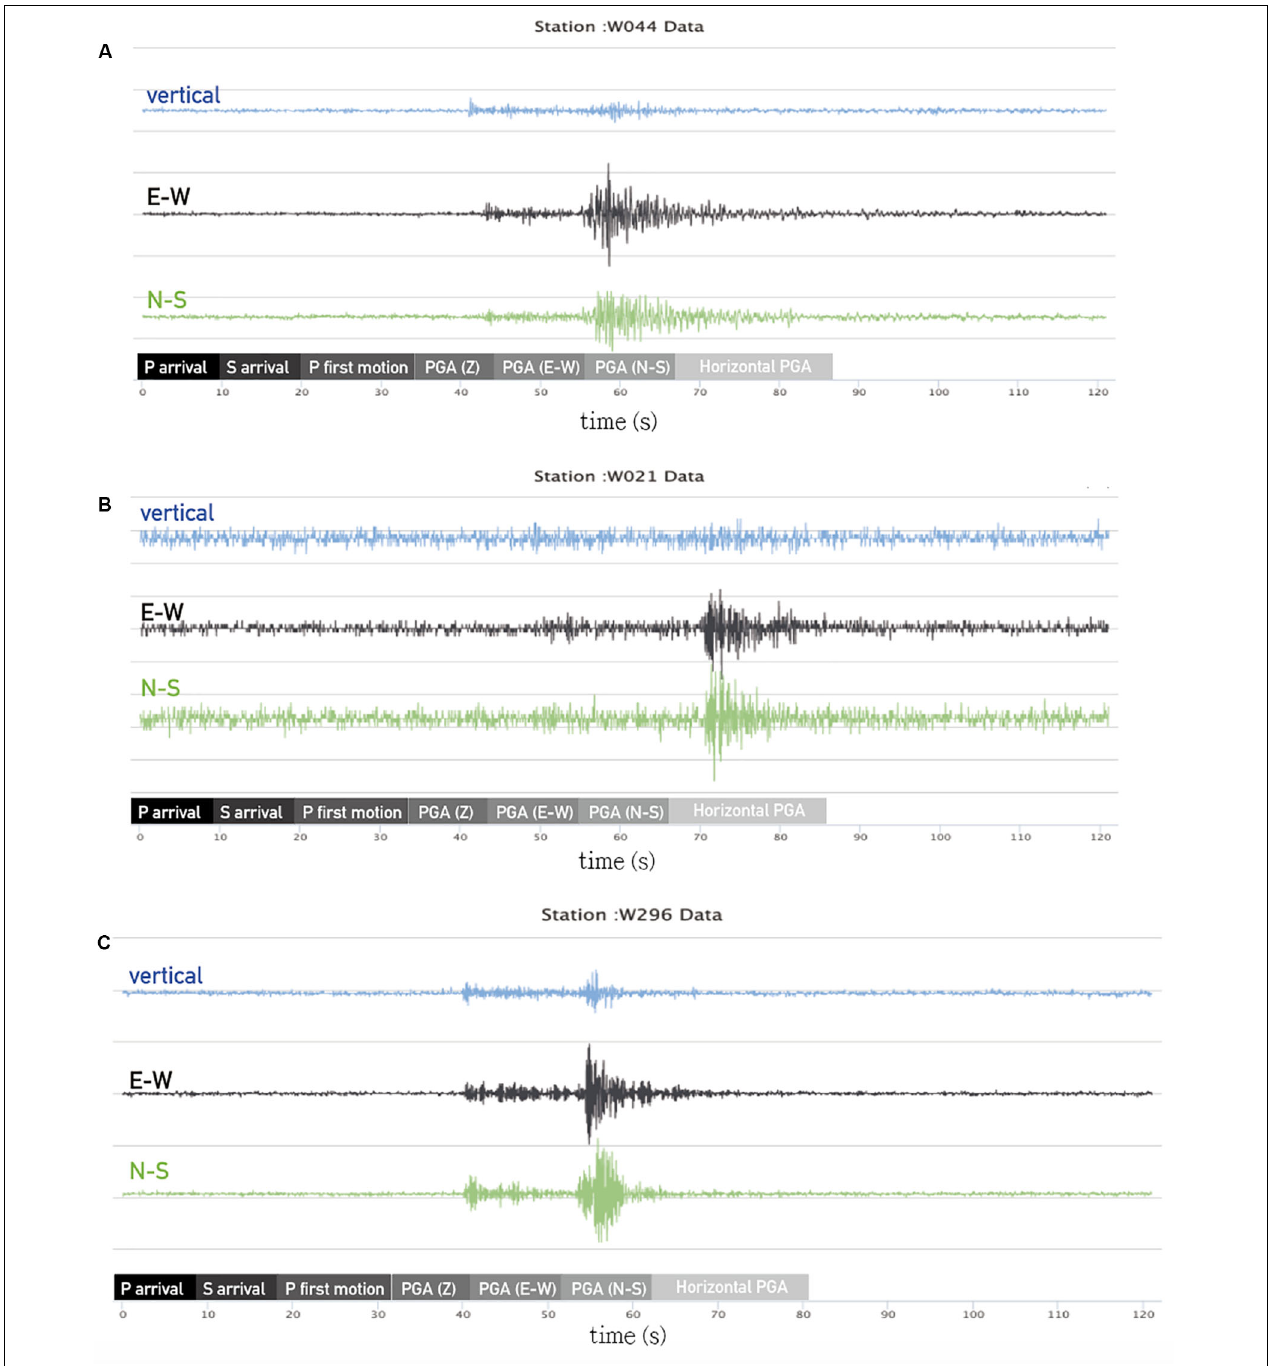
FIGURE 5 | Waveform examples for three selected stations in Figure 4B . For each station the process flow is shown in the